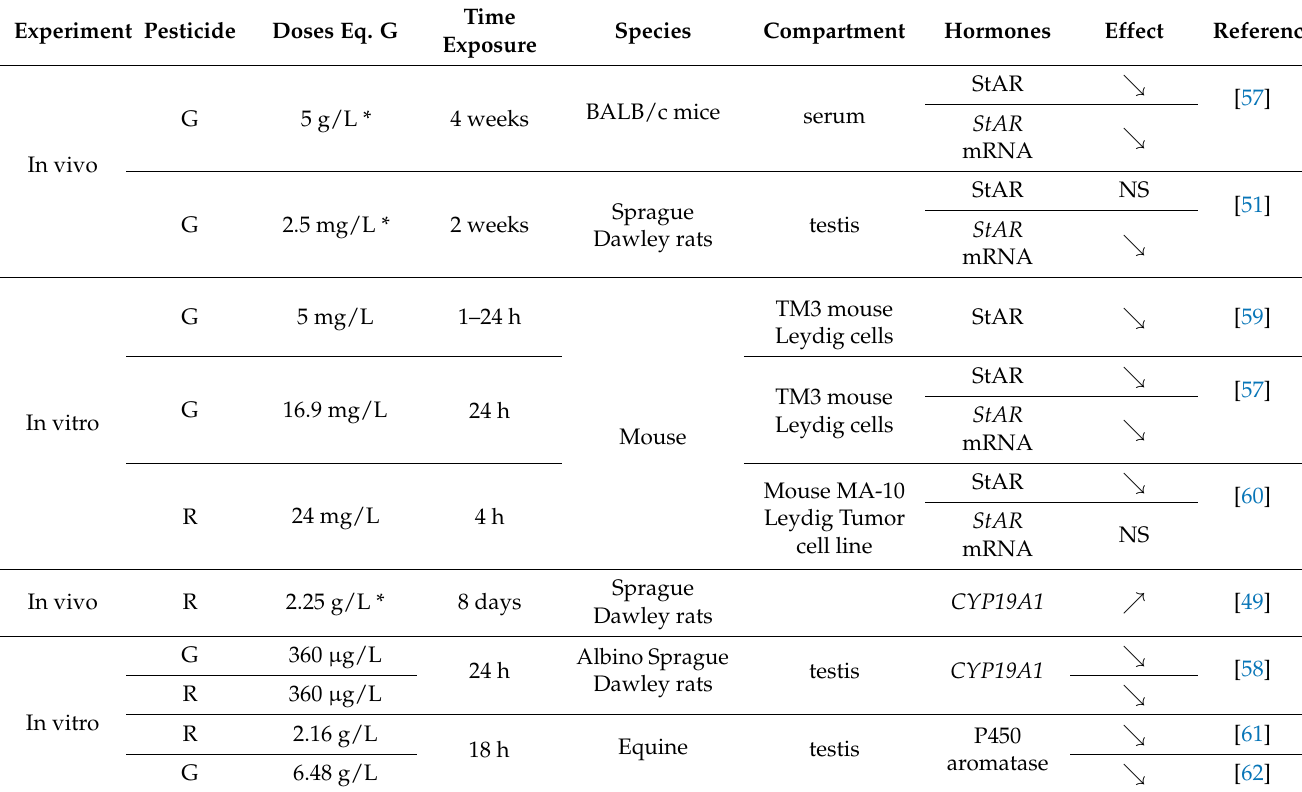
Table 6. Summary of studies on the impact of G or GBH exposure on steroidogenesis in adult males. Numbering in brackets indicates